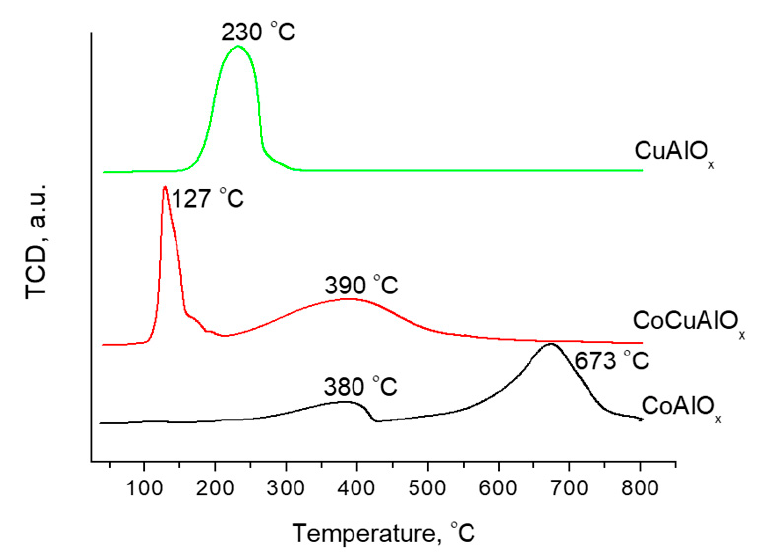
Figure 4. H 2 -TPR profiles of the CuAlO x , CuCoAlO x and CoAlO x